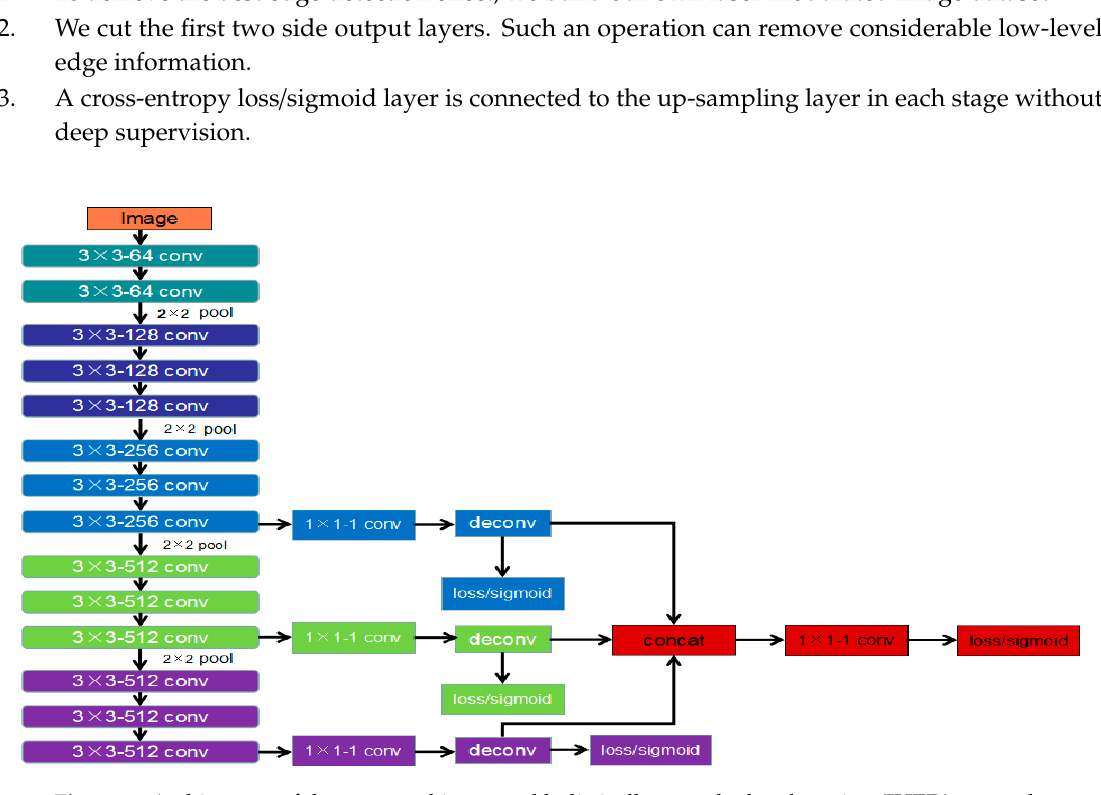
( d ) Figure 10. Two example images and ground-truth edge results for our dataset: ( a , c ) Input images; ( b , d ) ground-truth edges by human annotation of ( a , c ), respectively. In our IHED network, we consider the following objective function: ),(),( )( 1